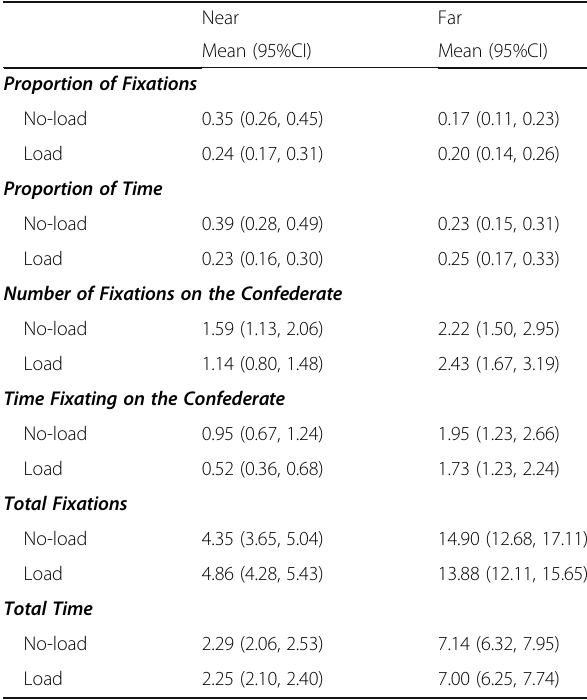
Table 6 Fixation behavior toward the confederate grouped by condition (no-load, load) and Proximity (near, far) in Experiment 3, time is reported in